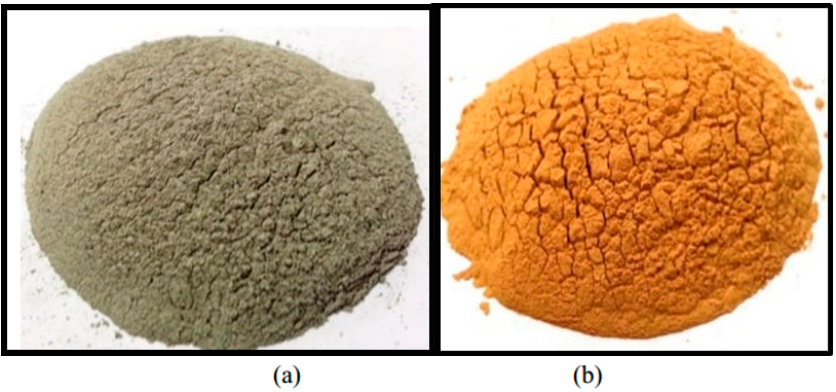
Figure 3. The FA powder used for synthesis of AL-FA composites ( a ) as-received condition, ( b ) after heat treatment condition [52].